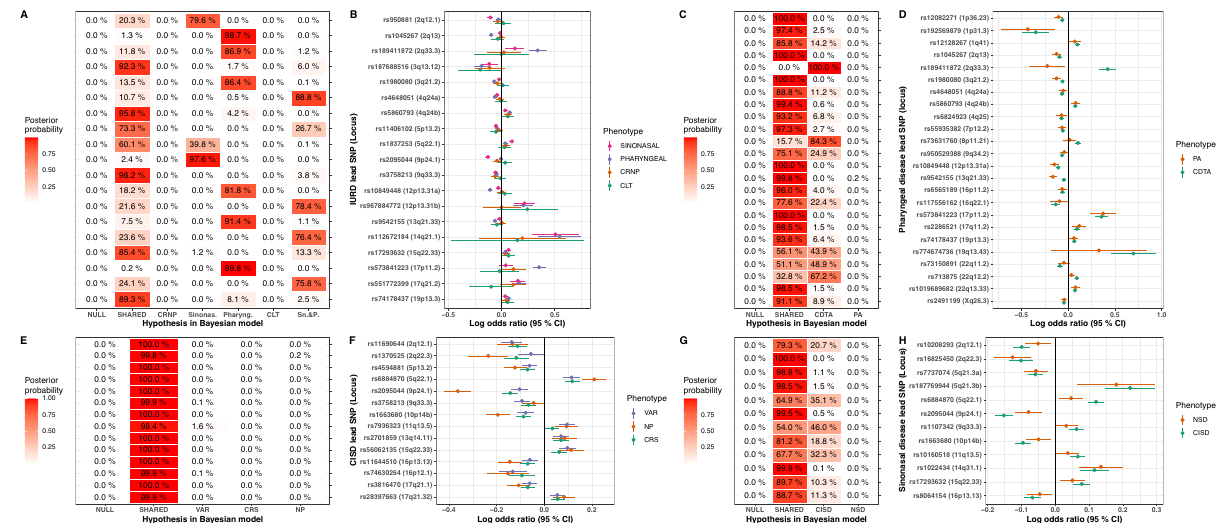
Fig. 3 | Shared impact between phenotypes for cross-trait analysis lead var- iants. A (upper left): Bayesian posterior probabilities of hypothetical models dis- played on the x-axis for IURD lead variants (y-axis; locus in parenthesis). Models correspond to NULL=null model; SHARED=Fixed or correlated effect model across phenotypes (CRNP, sinonasal disease, pharyngeal disease and CLT); CRNP=CRNP only; Sinonas.=sinonasal disease only; Pharyng.=pharyngeal dis- ease only; CLT=CLT only; Sn.&P.=Sinonasal AND pharyngeal disease ( fi xed- effect). A model with PIP>70% was considered likely. B (upper left): Odds ratio pointestimatesofIURDleadSNPsforphenotypes,with95%con fi denceintervals[ n (sinonasal)=25,235 cases, n (pharyngeal)=33,157 cases, n (CRNP)=6518 cases, n (CLT)=2623 cases]. C (upper right): Bayesian posterior probabilities of hypothe- ticalmodelsdisplayedonthe x axisforpharyngealdiseaseleadSNP( y axis).Models correspond to NULL=null model; CORR=Fixed or correlated effect model across